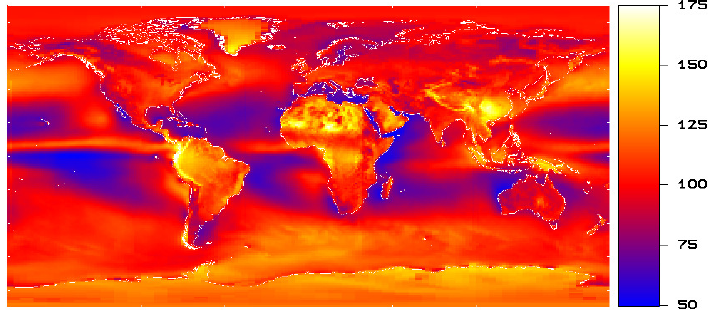
Figure 4. The 10-year mean CERES EBAF Reflected Solar Flux.